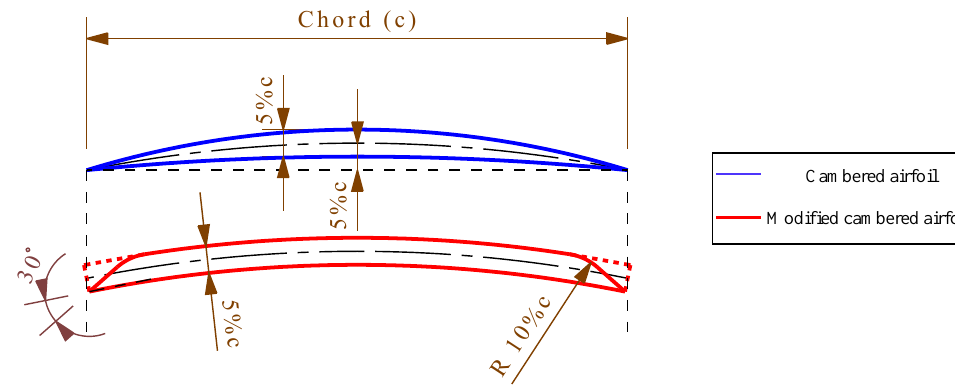
Figure 1. Airfoil geometry: the cambered plate with very thin edges (blue color), and the cambered plate with constant thickness modified due to construction limits (red